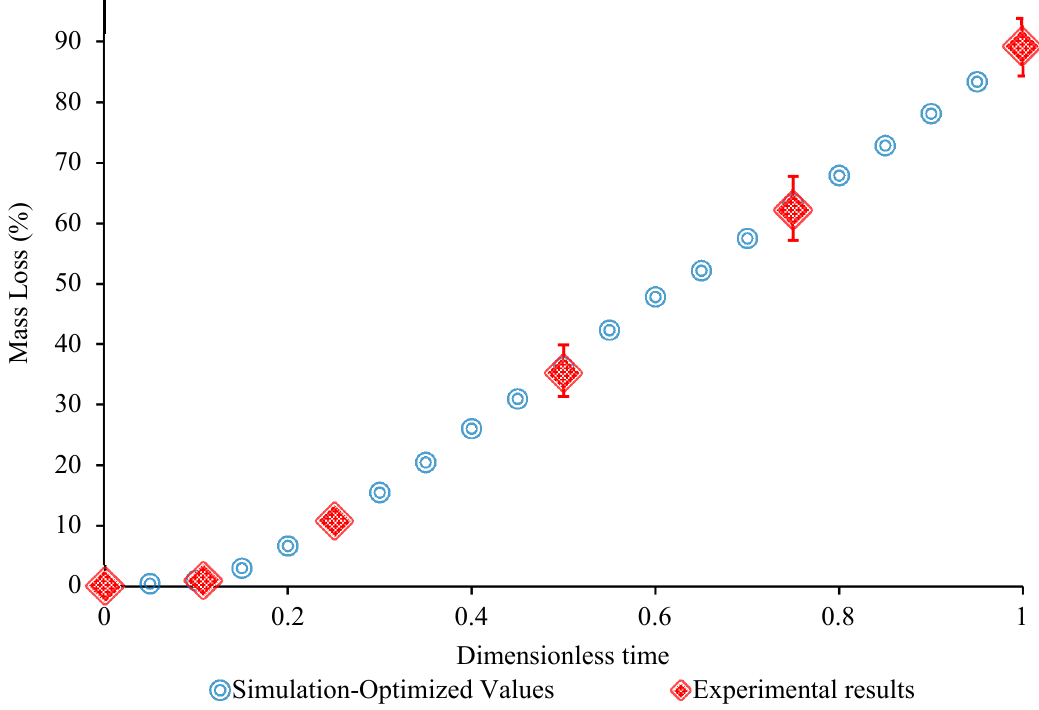
Figure 9. Mass loss (%) vs. dimensionless time as measured in immersion test of Mg–1.2Zn–0.5Ca alloy (n = 7) and corresponding FE simulation predictions.